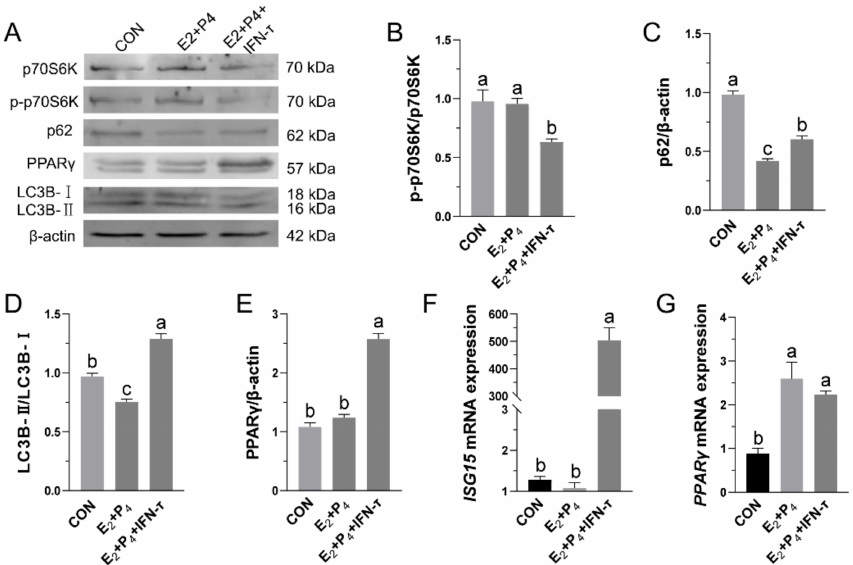
Figure 2. Effects of hormone treatment on PPAR γ and mTOR pathway proteins: ( A – E ) After 12 h of hormone treatment, the expression of p70S6K, p-p70S6K, p62, LC3B-I, LC3B-II and PPAR γ in STCs was determined by Western blotting (Figure S1). Real-time quantitative PCR analysis of ( F ) ISG15 and ( G ) PPAR γ in STCs. The β -actin gene was used as a normalization control. In the CON group, 0.1% DMSO was added. Data are shown as the mean ± standard deviation (SD) of three independent trials. Different letters above the bars indicate significant differences ( p <